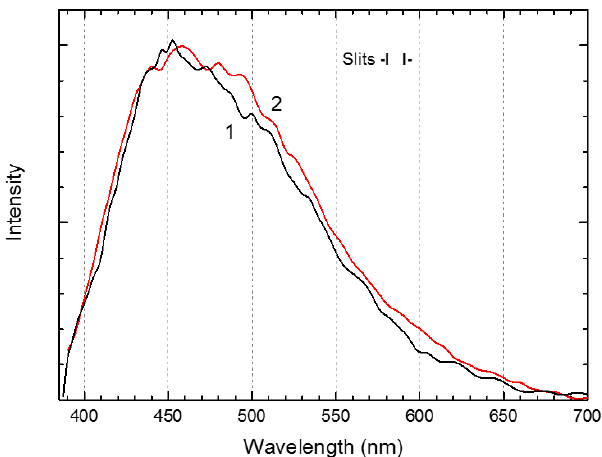
Fig. 4. Fluorescence spectra of hemodialysate (1) and urine fraction powder (2) at excitation 370 nm at T ¼ 295 K. An average spectral width of the monochromator slits is shown by brackets.